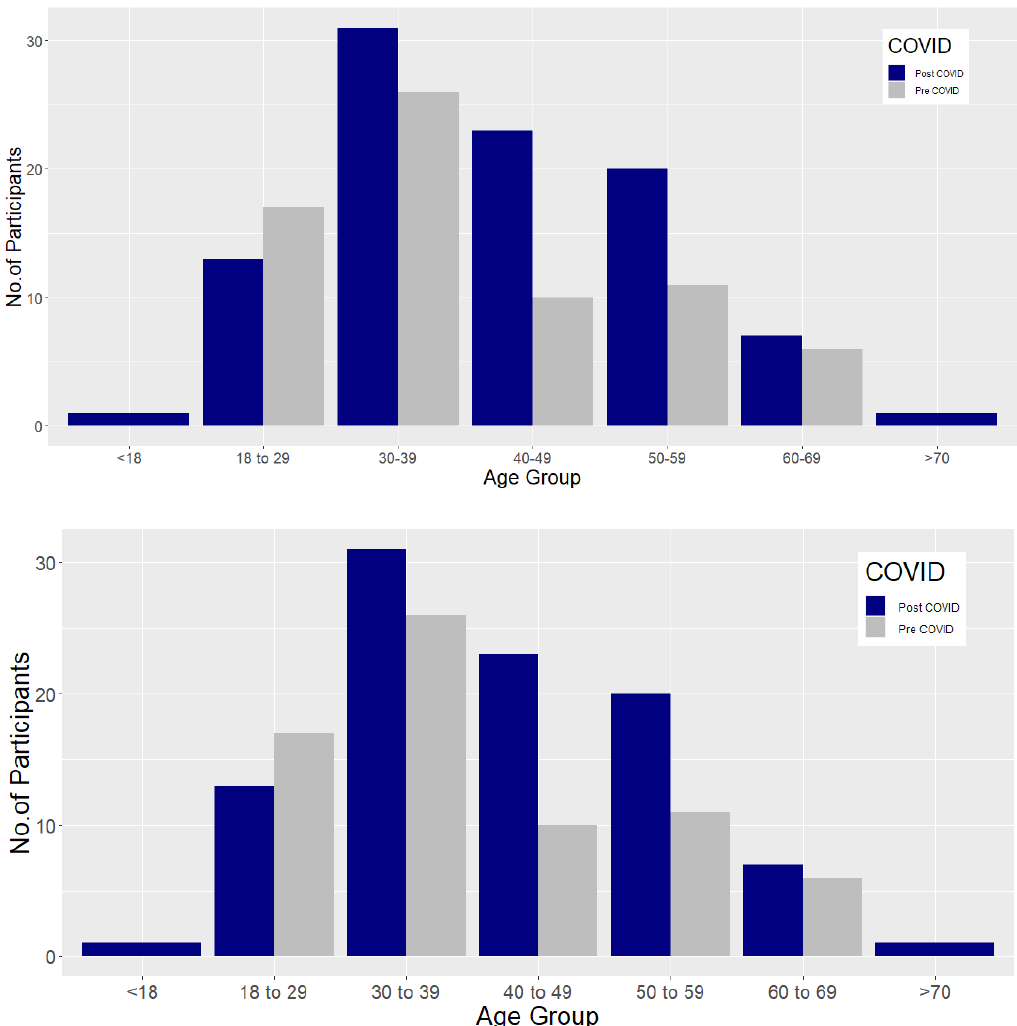
Figure 1. Comparative Age Demographic ( n = 166).